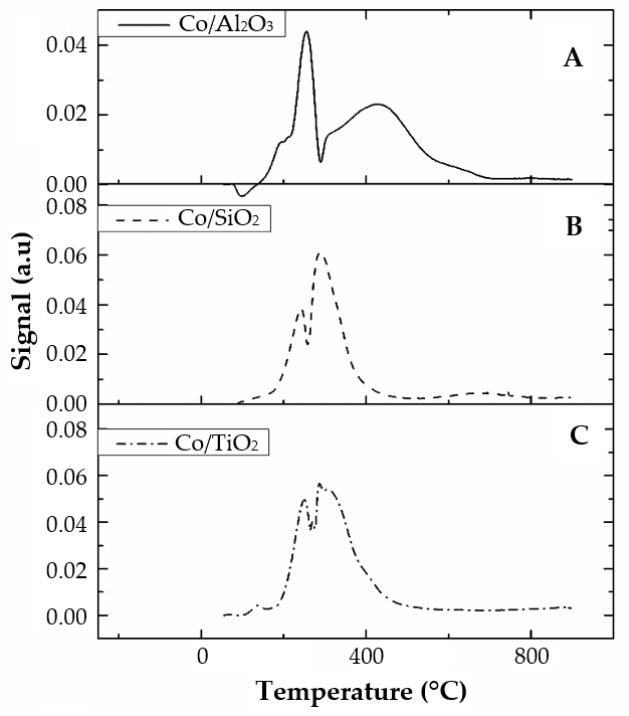
Figure 3. TPR reduction profiles for ( A ) Co/Al 2 O 3 (solid line), ( B ) Co/SiO 2 (dashed line), and ( C ) Co/TiO 2 (dashed and dotted line). Reproduced from Shiba et al. [27] with permission from Else- vier, license number 5053041467597.